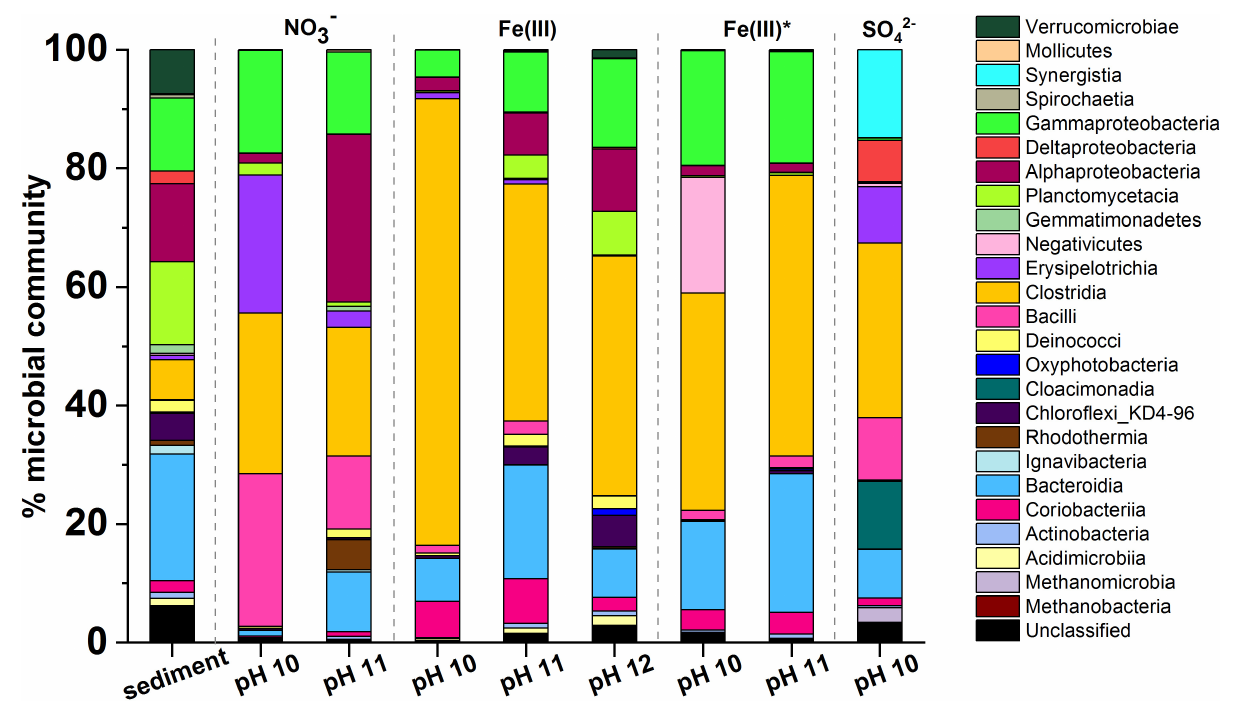
FIGURE 5 | Microcosm microbial community profiles by phylogenetic class. In all incubations there was an increase in the relative abundance of Gram-positive Firmicutes. Clostridia was the dominant class in most samples. Other key classes observed included Gammaproteobacteria, Alphaproteobacteria, Bacteroidia, and Bacilli. The sulfate-reducing microcosm had a significantly different population when compared to the other microcosms and this included Synergistia, Deltaproteobacteria, and